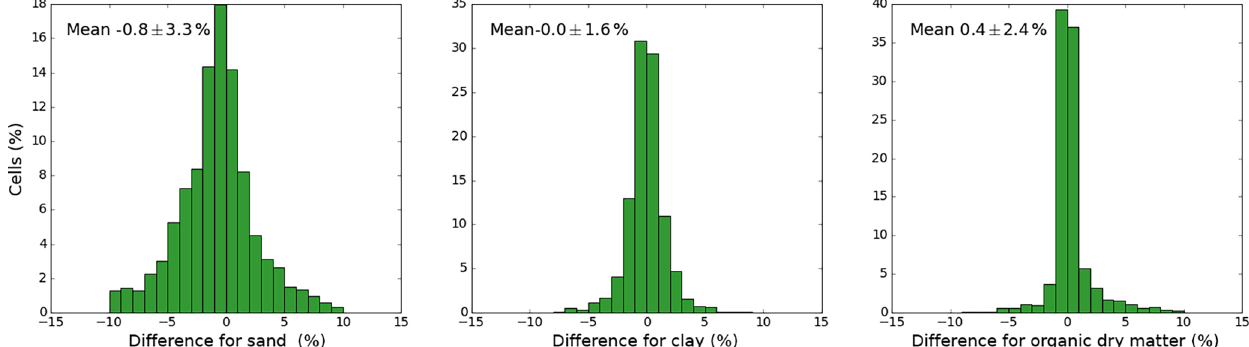
Figure A6. Histogram of the difference between the mean clay, sand, and organic matter content for CLASS-CTEM grid cells based on the simple mean value of all GSDE cells and the weighted mean of the clusters within a CLASS-CTEM grid cell.